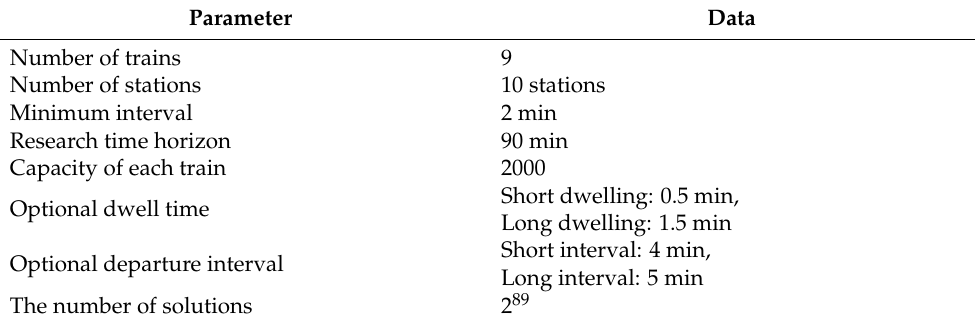
Table 4. Infrastructure parameters of Beijing Metro Line